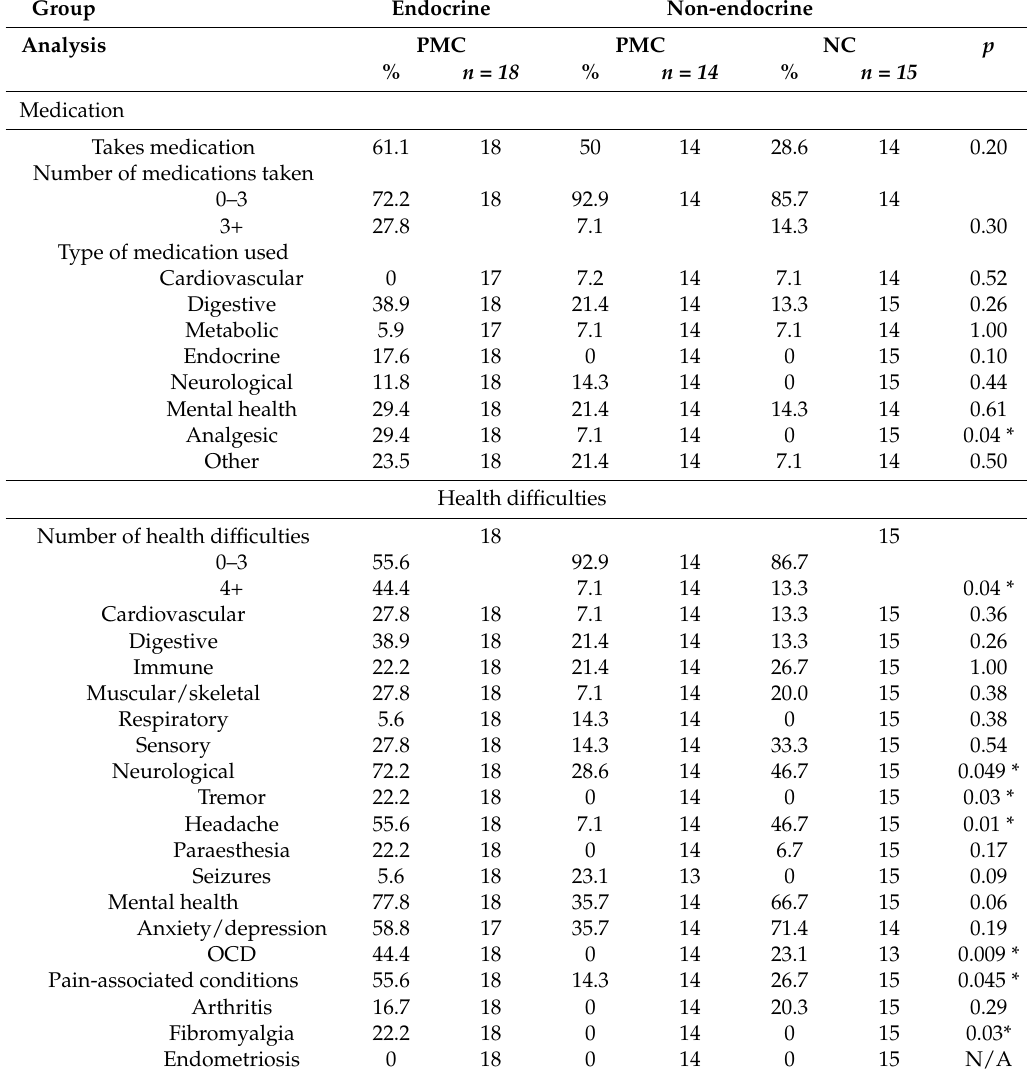
Table 4. Physical and mental health issues in